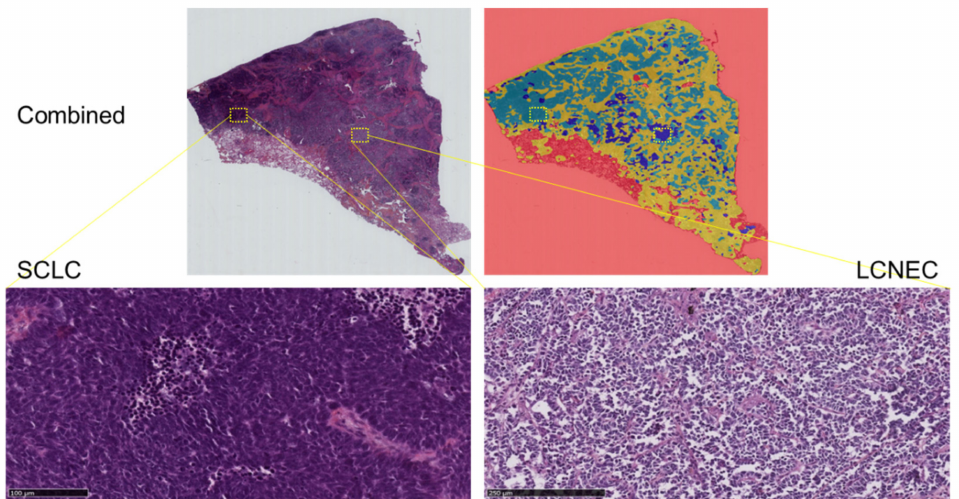
Figure 2. Representative example of raw images of a combined SCLC with LCNEC with an overlap of the HES slide and the corresponding probability maps obtained with the HALO-AI lung NET module trained by the